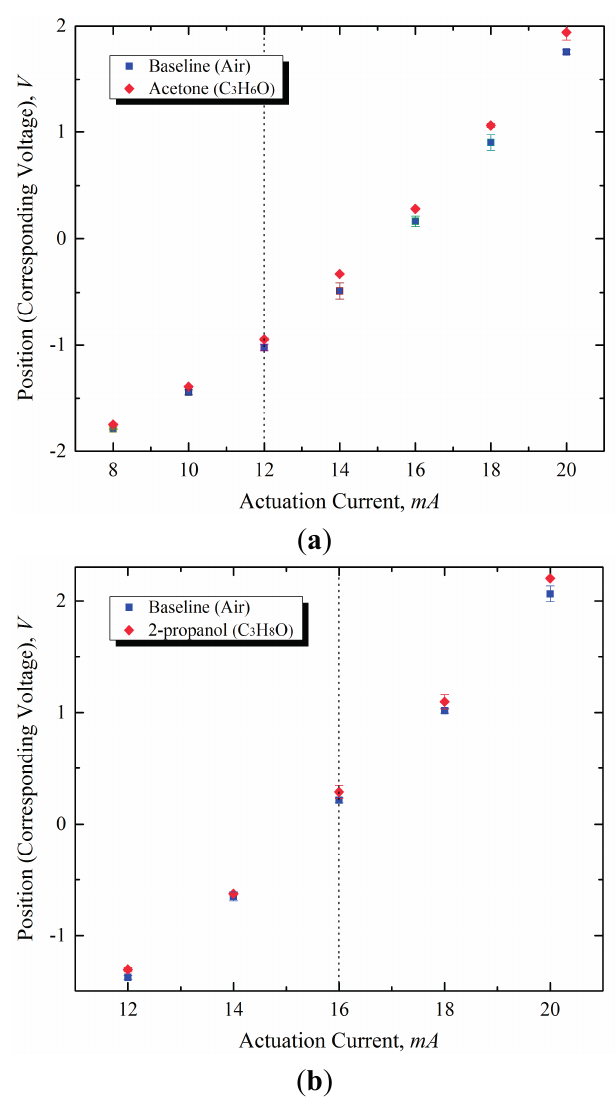
Figure 12. Experimental results of microcantilever deflection based on optical lever method in explosive sensing ( a ) acetone and ( b )